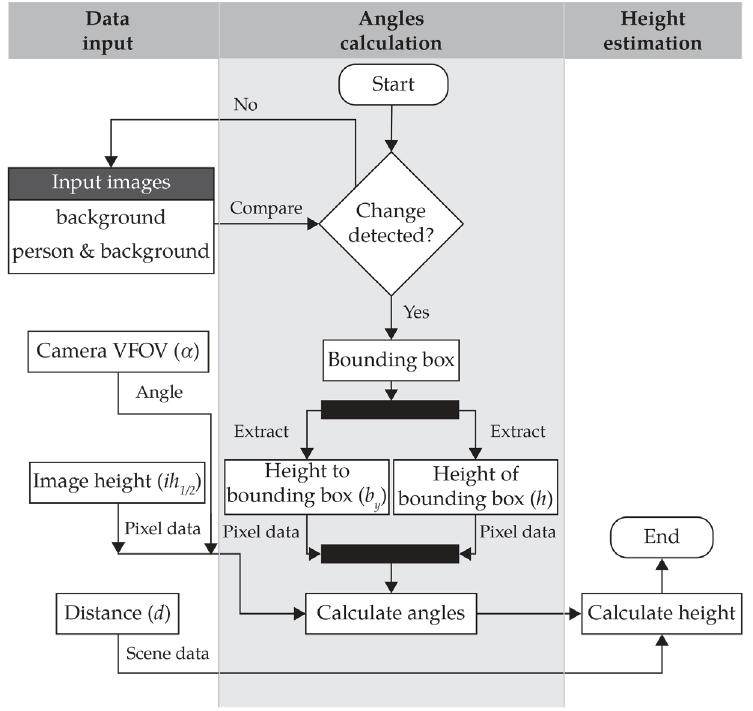
Figure 1. Main steps of the approach to the height estimation using angles